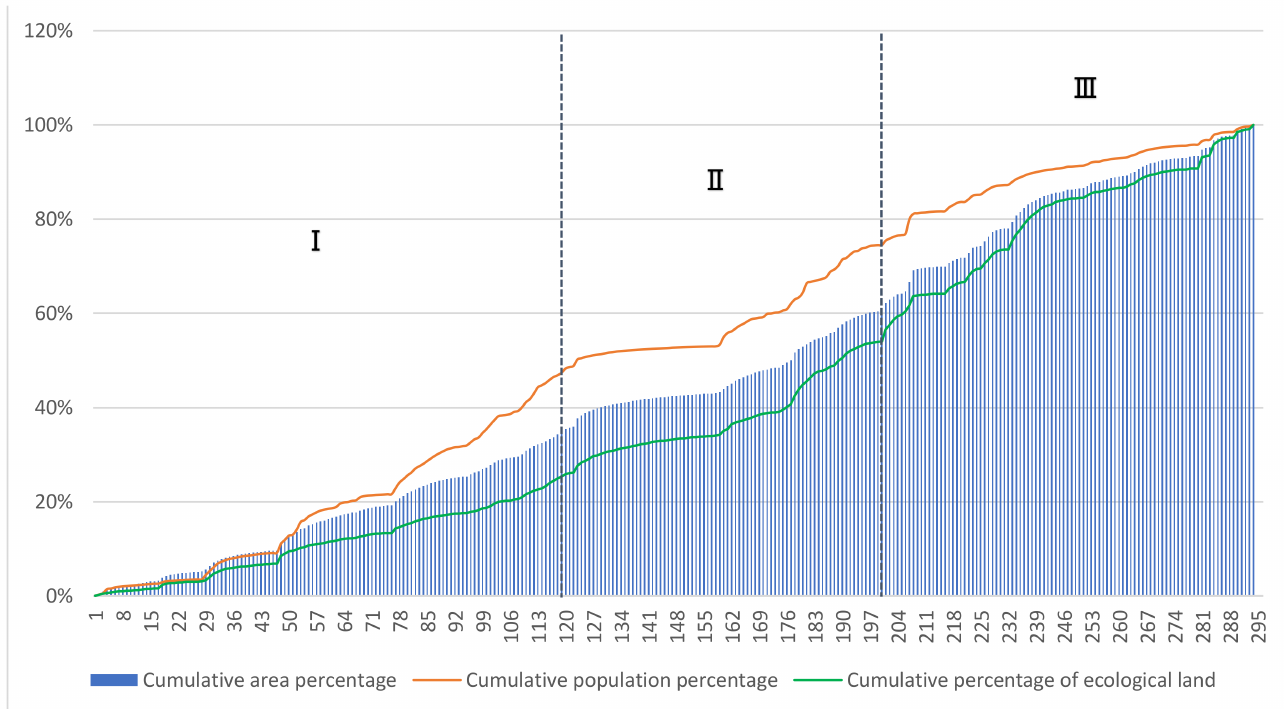
Figure 7. People–land–greenspace percentage accumulation